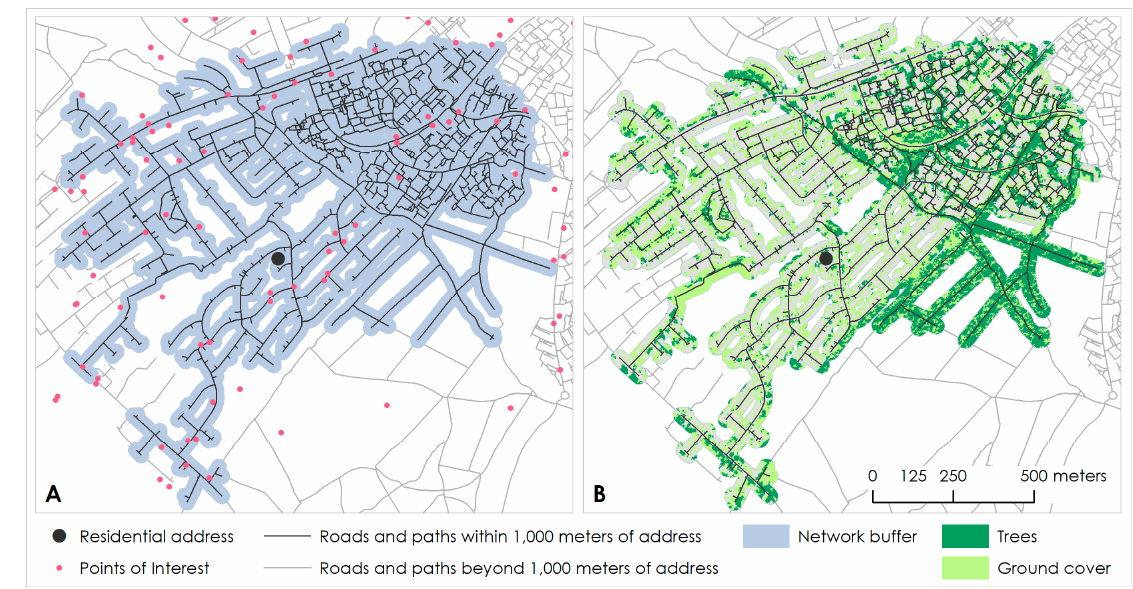
Figure 1. Example of a road/path network within 1000 m of a (dummy) cohort participant residential address, with a 50 m width buffer of the road/path network. Panel ( A ) shows points of interest (e.g., shops and public transport stops; pink) and panel ( B ) shows trees (dark green) and ground cover (light green) in the network buffer.